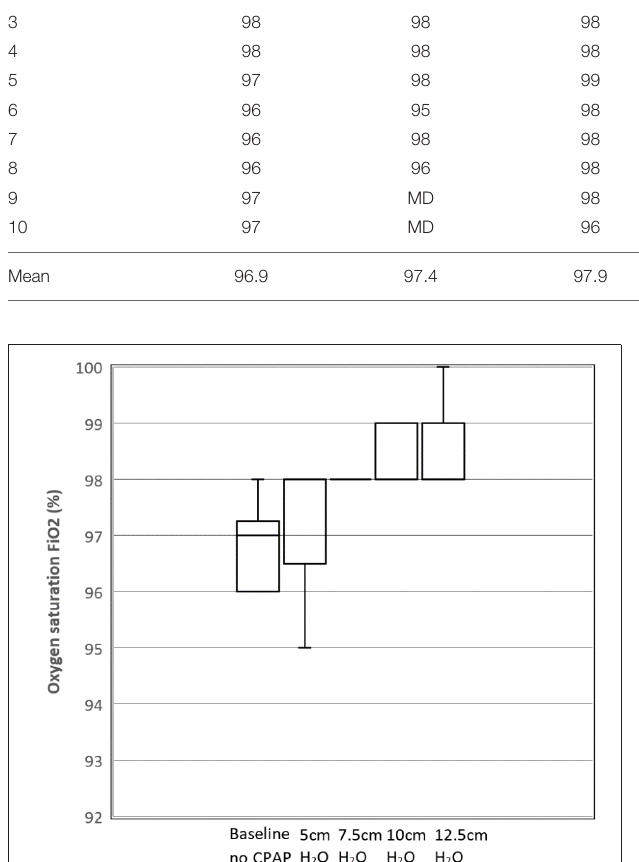
FIGURE 8 | Box and whisker plot showing mean oxygen saturation levels as a function of CPAP levels for the 10 participants. N = 10 for Baseline, 7.5, 10, 12.5cm H 2 O; N = 8 for 5cm H 2 O (due to missing